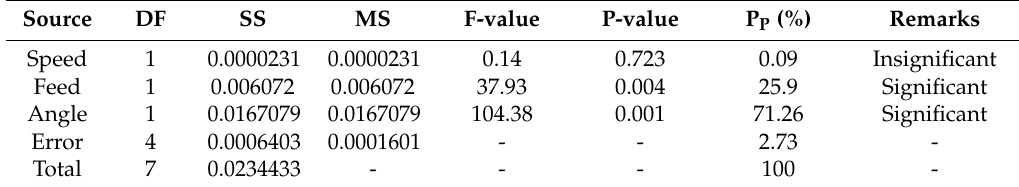
Table 9. ANOVA results for the pivot-point distance from machined surface.